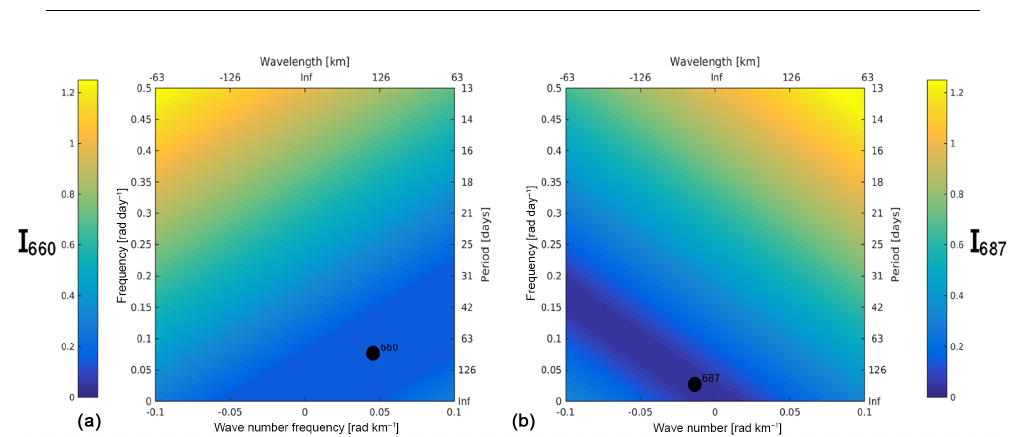
Figure 3. Difference between observed Lagrangian float wave parameters and Lagrangian theoretical wave ones (index I ) for (a) float 660 and (b) float 687. Negative wavelengths describe westward waves. Black dots indicate the observed Lagrangian